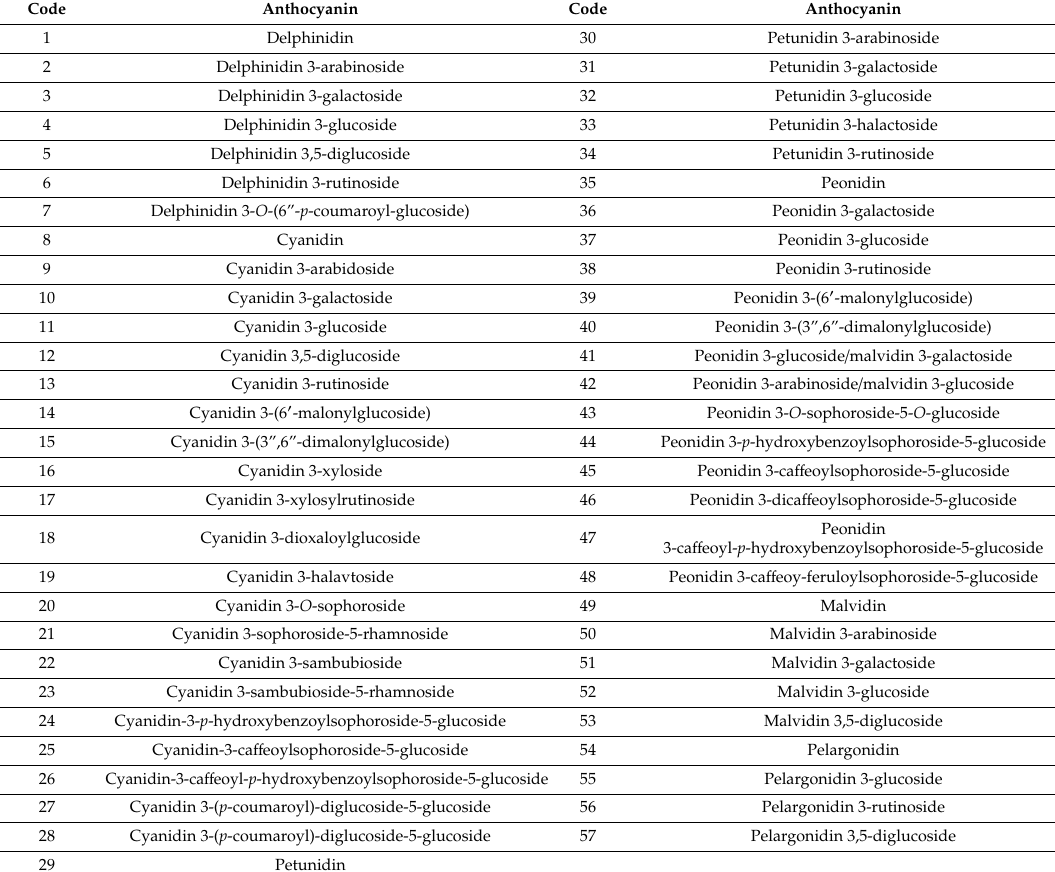
Table 2. Anthocyanins identified in di ff erent fruits, vegetables, and edible flowers and their